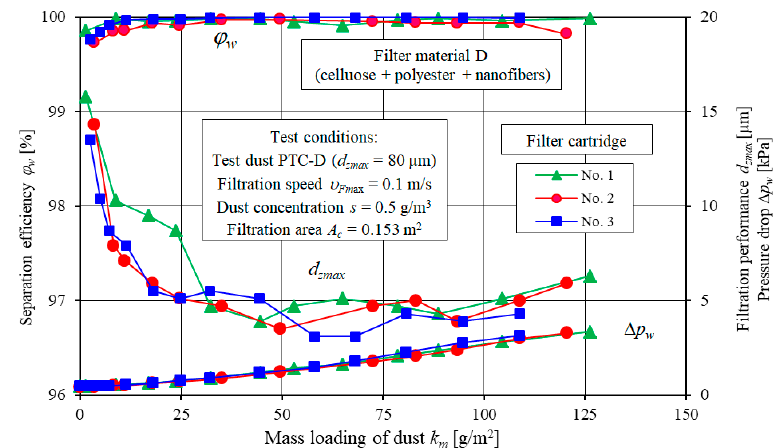
Figure 6. Separation efficiency φ w , filtration performance d zmax and pressure drop Δ p w as a function of dust mass loading k m for three filter elements D specimens.